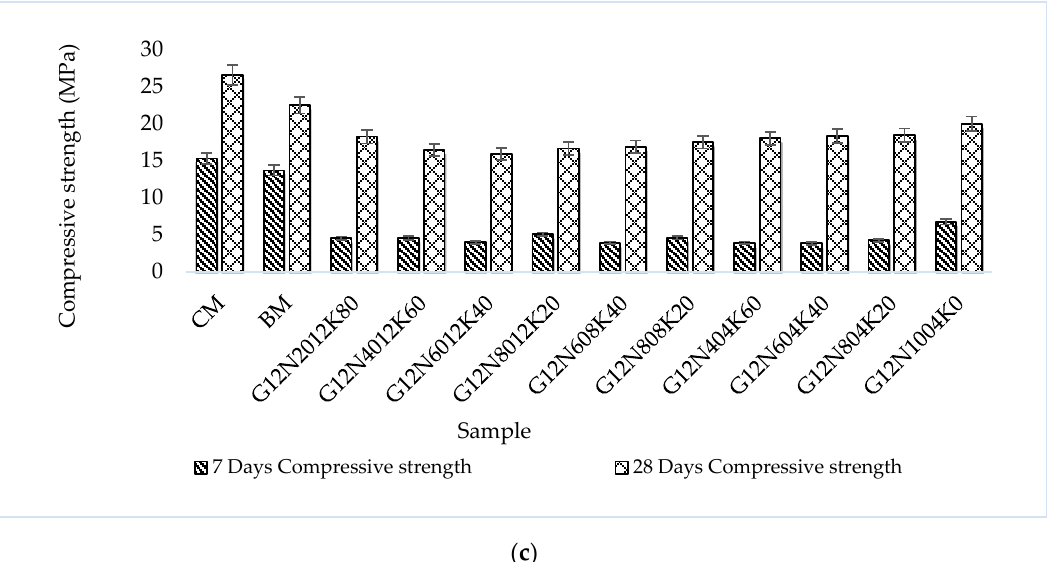
Figure 9. Compressive strength at 7 and 28 days: ( a ) for 4 M samples, ( b ) for 8 M samples, and ( c ) for 12 M samples.